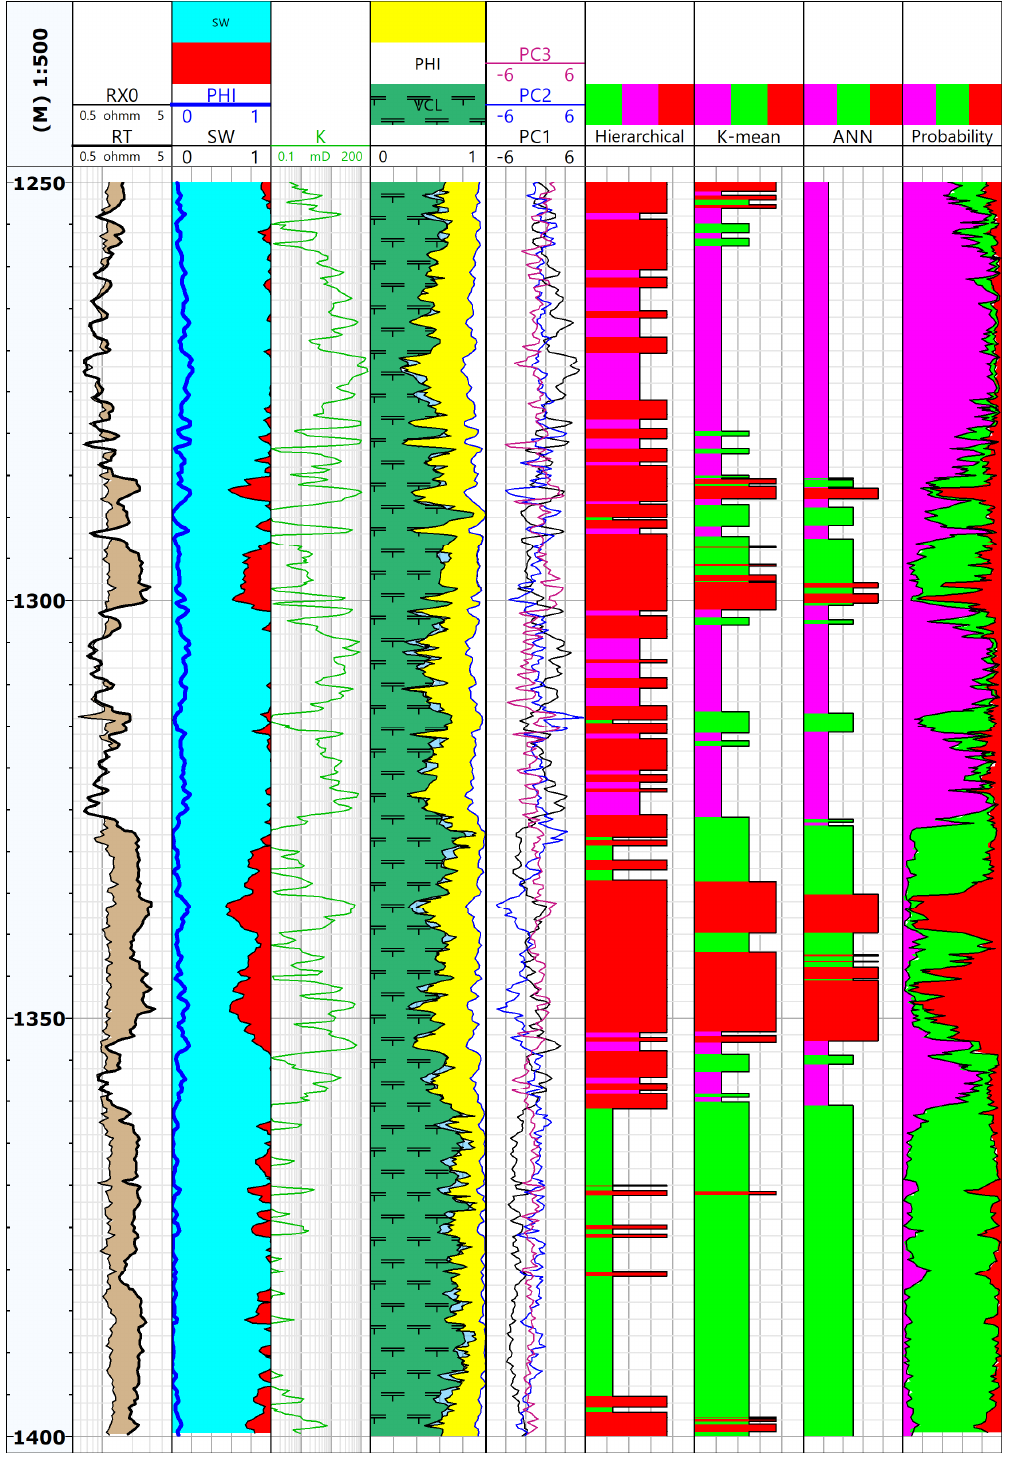
Figure 4. Results of measured log (1 track), standard comprehensive well log data interpretation (track 2–4) and statistical analysis (track 5–9), W-1 well. Colours for facies identification: A–violet, B–green, C–red.